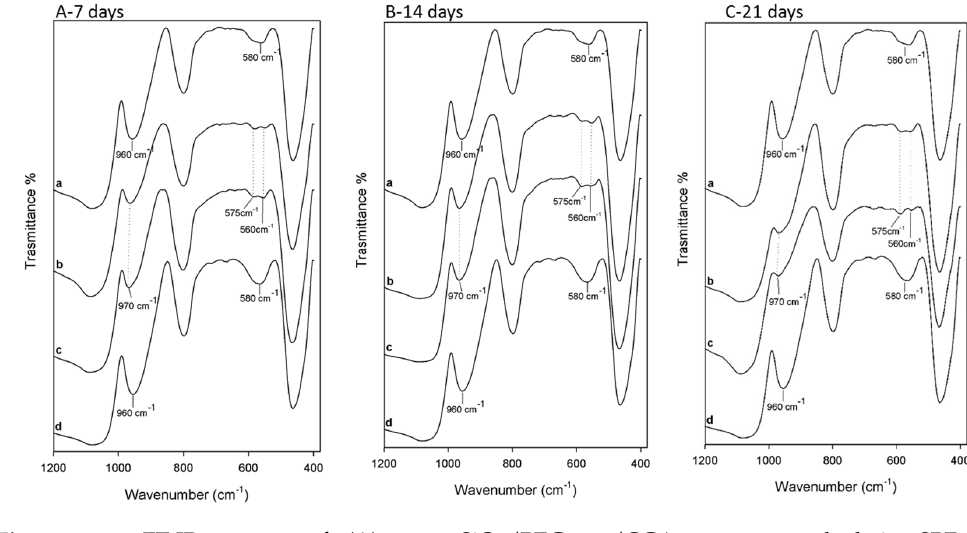
Figure 5. FT-IR spectra of ( A ) a. SiO 2 /PEG 6wt% /CGA 5wt% not soaked in SBF; b. SiO 2 /PEG 6wt% /CGA 5wt% c. SiO 2 /PEG 6wt% /CGA 10wt% after 7 days of exposure to SBF d. SiO 2 /PEG 6wt% /CGA 10wt% not soaked in SBF. ( B ) a. SiO 2 /PEG 6wt% /CGA 5wt% not soaked in SBF; b. SiO 2 /PEG 6wt% /CGA 5wt% c. SiO 2 /PEG 6wt% /CGA 10wt% after 14 days of exposure to SBF d. SiO 2 /PEG 6wt% /CGA 10wt% not soaked in SBF. ( C ) a. SiO 2 /PEG 6wt% /CGA 5wt% not soaked in SBF; b. SiO 2 /PEG 6wt% /CGA 5wt% c. SiO 2 /PEG 6wt% /CGA 10wt% after 21 days of exposure to SBF d. SiO 2 /PEG 6wt% /CGA 10wt% not soaked in SBF.